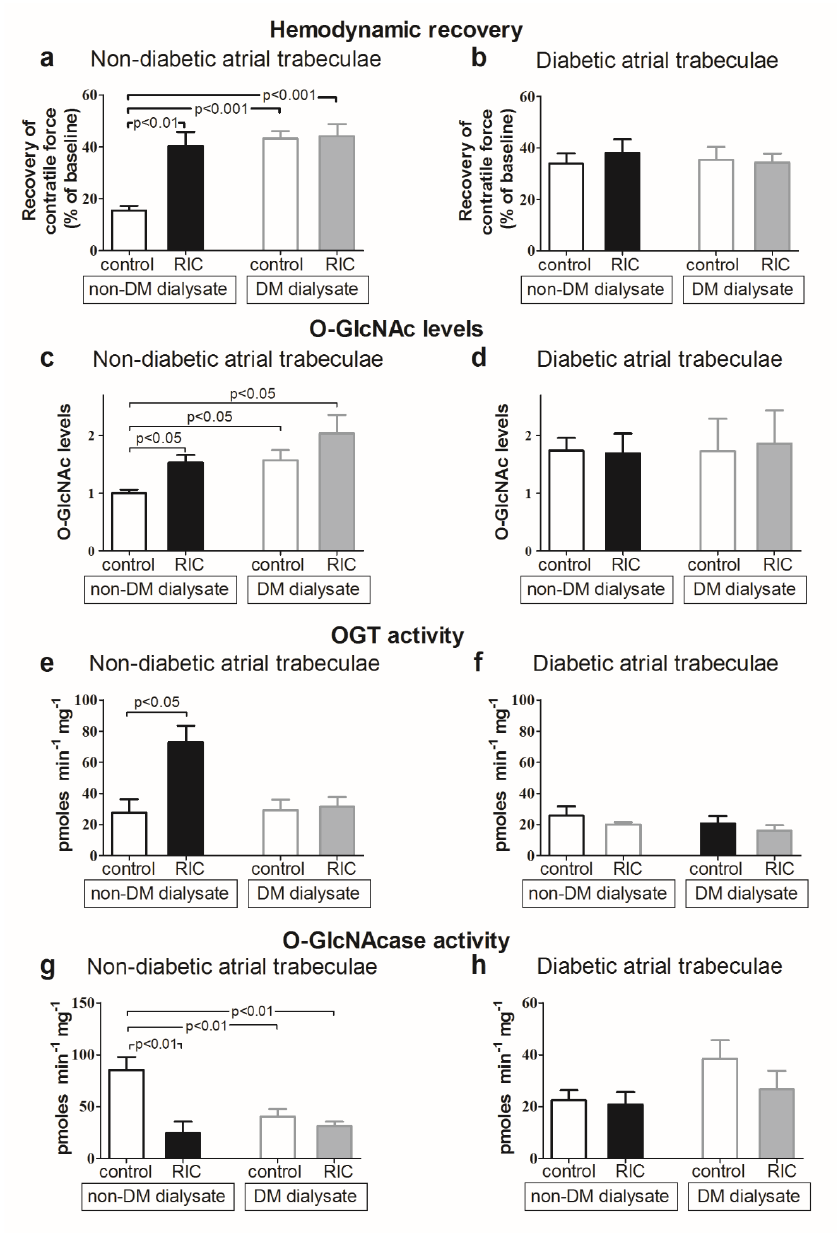
Figure 2. ( a , b ) Recovery of contractile force in atrial trabeculae from non-diabetic ( a ) and diabetic ( b ) patients, perfused with control and RIC dialysate from non-diabetic and diabetic patients; ( c,d ) O-GlcNAc levels in atrial trabeculae from non-diabetic ( c ) and diabetic ( d ) patients, perfused with control and RIC dialysate from non-diabetic and diabetic patients; ( e,f ) OGT activity in atrial trabeculae from non-diabetic ( e ) and diabetic ( f ) patients, perfused with control and RIC dialysate from non-diabetic and diabetic patients; ( g,h ) O-GlcNAcase activity in atrial trabeculae from non-diabetic ( g ) and diabetic ( h ) patients, perfused with control and RIC dialysate from non-diabetic and diabetic patients. Data are mean ± SEM. Originally published Cardiovasc Res. 2013 Feb 1; 97(2): 369–378 [23]. Reproduced with